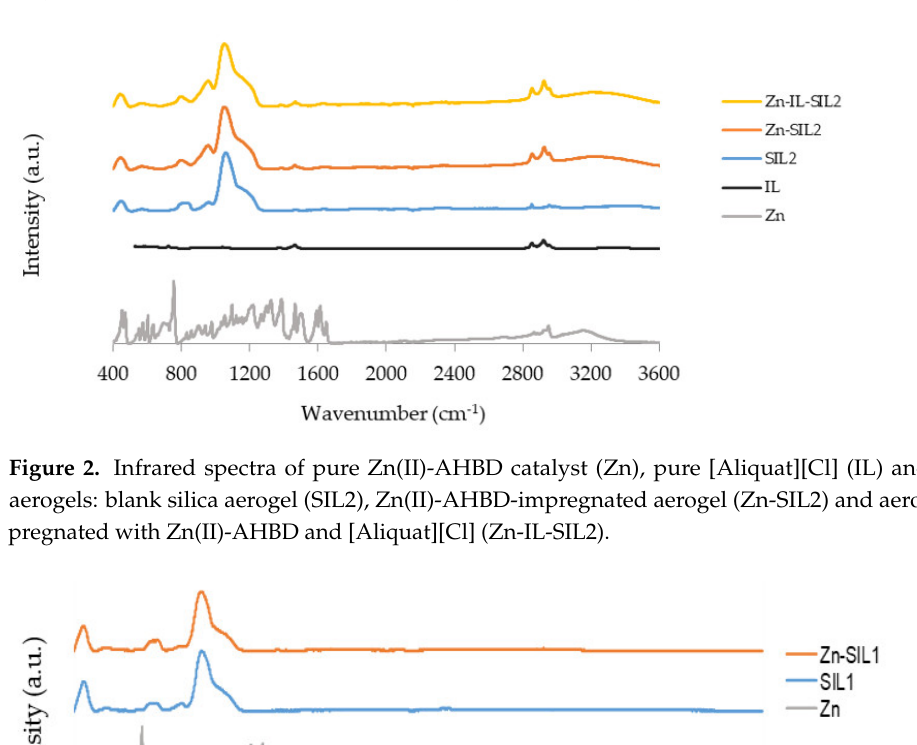
Figure 2. Infrared spectra of pure Zn(II)-AHBD catalyst (Zn), pure [Aliquat][Cl] (IL) and silica aer- ogels: blank silica aerogel (SIL2), Zn(II)-AHBD-impregnated aerogel (Zn-SIL2) and aerogel impreg-